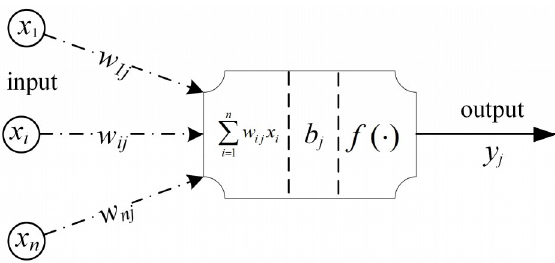
Figure 1. Schematic of the basic structure of a neuron. Figure 1 is reproduced from reference [50].